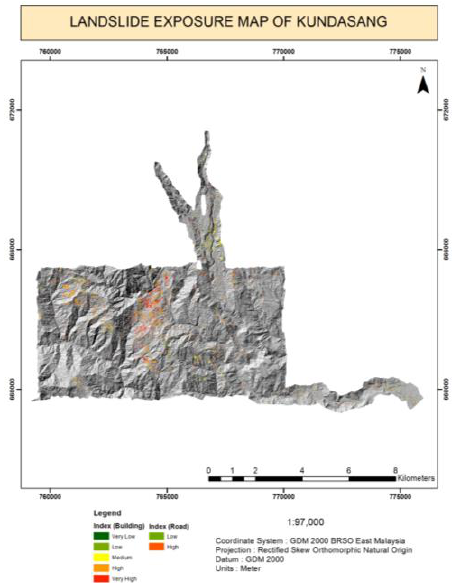
Figure 8. Landslide Exposure map of